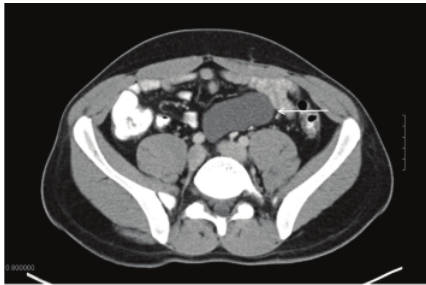
Figure 1: CT of the abdomen and pelvis shows an 8cm homoge- nous cystic lesion (white arrow).